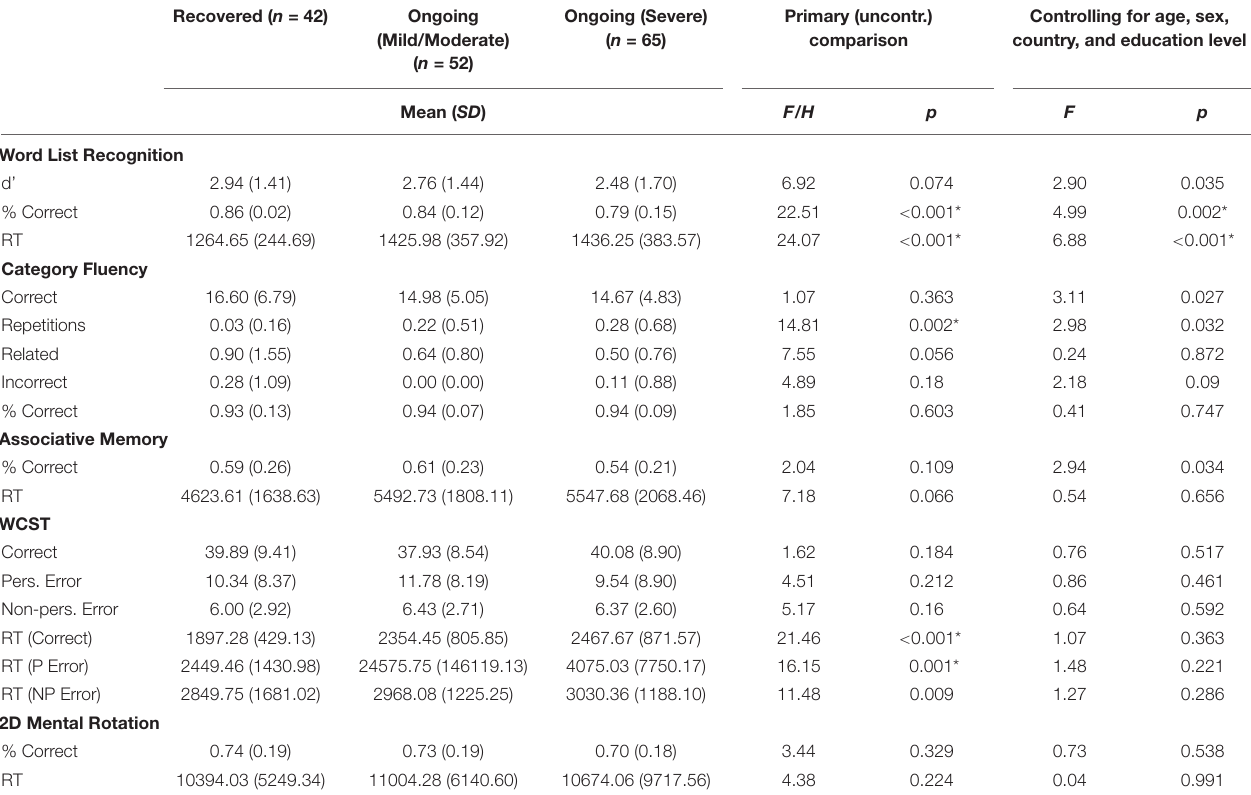
TABLE 3 | Cognitive task results among Recovered, Ongoing (Mild/Moderate), and Ongoing (Severe) groups. Recovered ( n = 42) Ongoing Ongoing (Severe) Primary (uncontr.) Controlling for age, sex, (Mild/Moderate) ( n = 65) comparison country, and education ( n = 52)